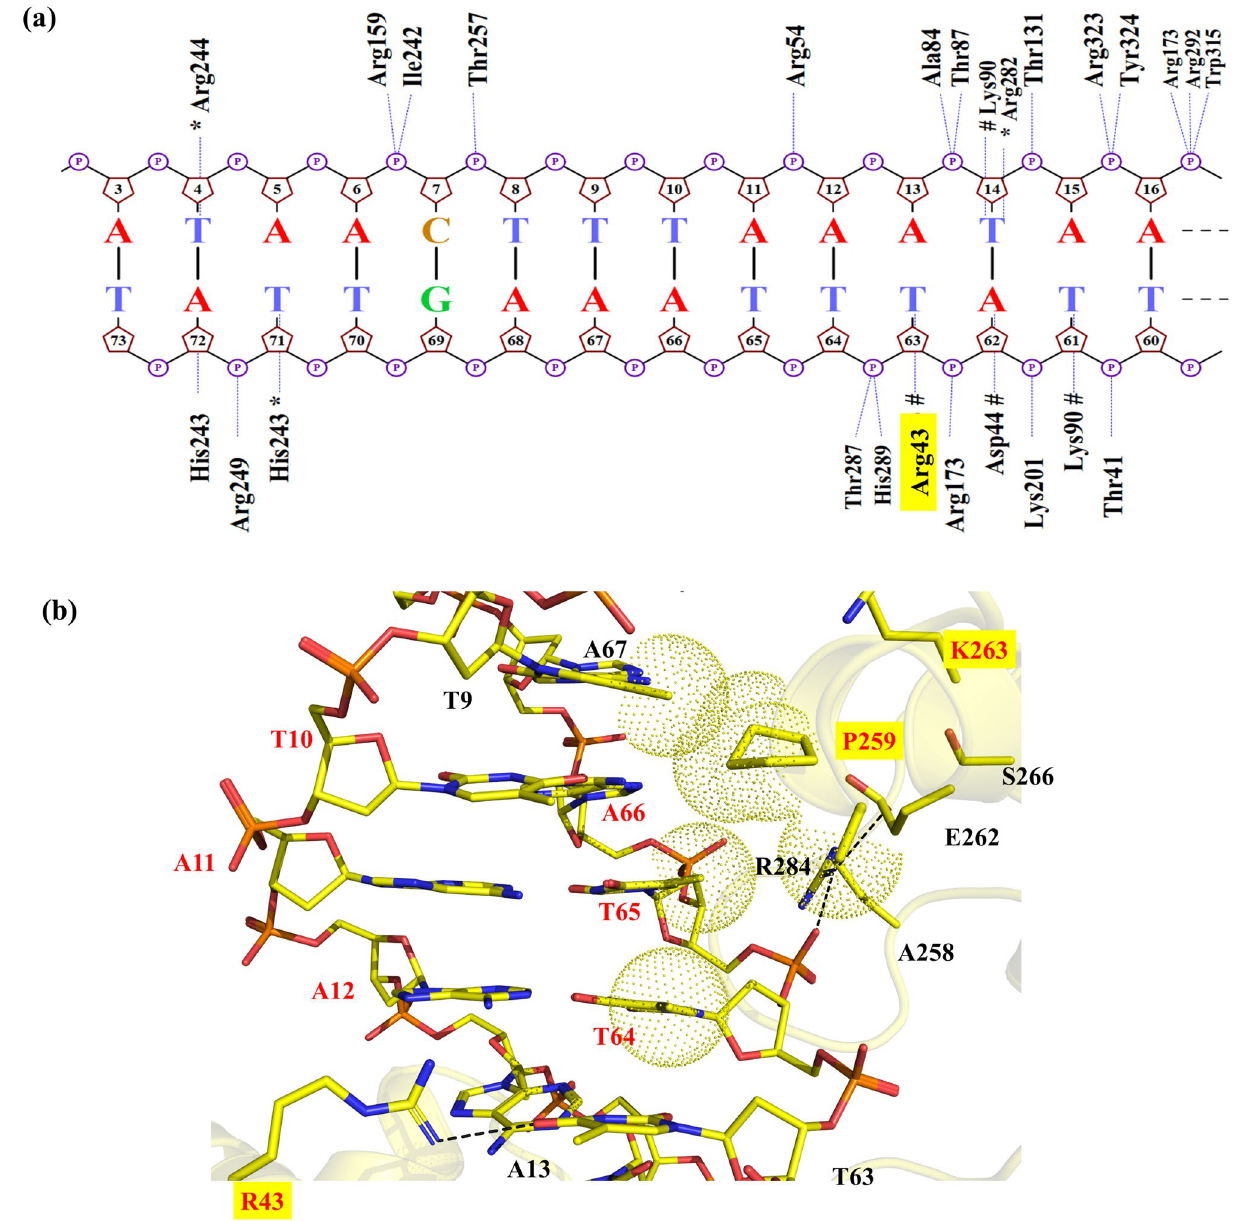
Figure 3. Analysis of protein-DNA interactions observed in the MD simulation of Dre/ rox ( a ) Projection of hydrogen bond interactions spotted in the last frame of the Dre/ rox MD trajectory. The base-specific interactions with the minor groove are labeled with an asterisk (*). Hashes (#) denote the interactions with the DNA major groove. Nucplot was used to generate the image. ( b ) Detailed view of interactions observed in the PDI BJ area of the Dre/ rox complex based on MD simulations. The specificity-determining residues are highlighted with a yellow box. Hydrogen bonds are shown in black dashed lines and van der Waals interactions in dotted spheres. Pymol was used to generate the image (version 2.1, https ://pymol